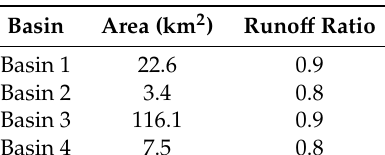
Figure 8. Catchment division diagram.